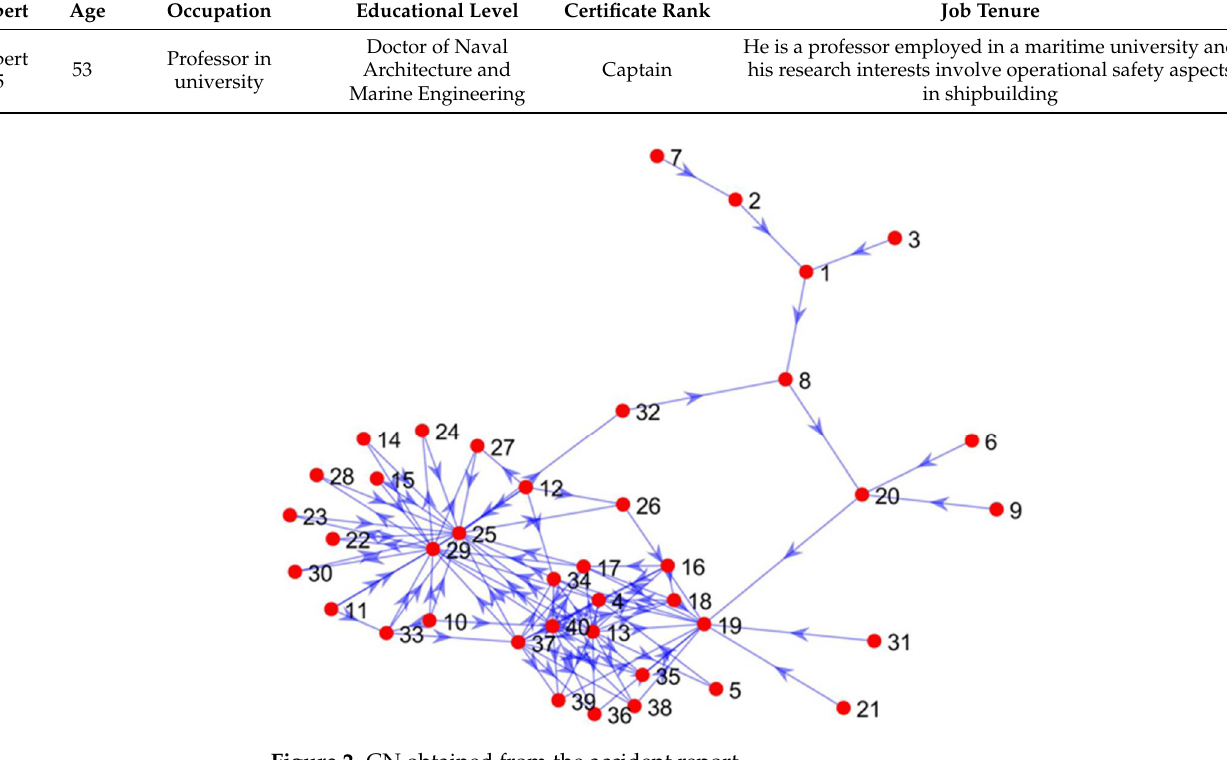
Figure 2. CN obtained from the accident